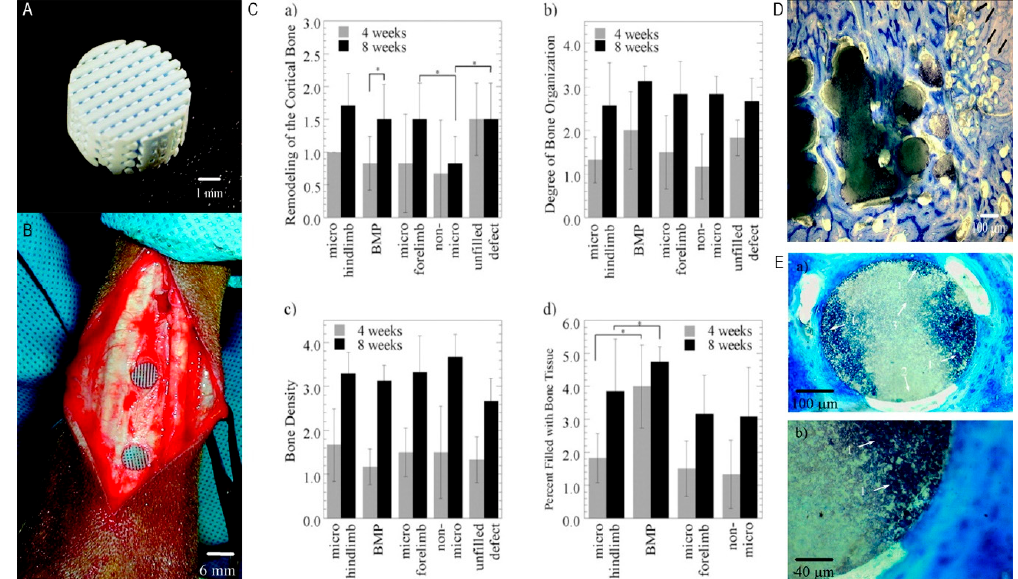
Figure 15. ( A ) Scaffold fabricated by directed deposition method. ( B ) The image of HA